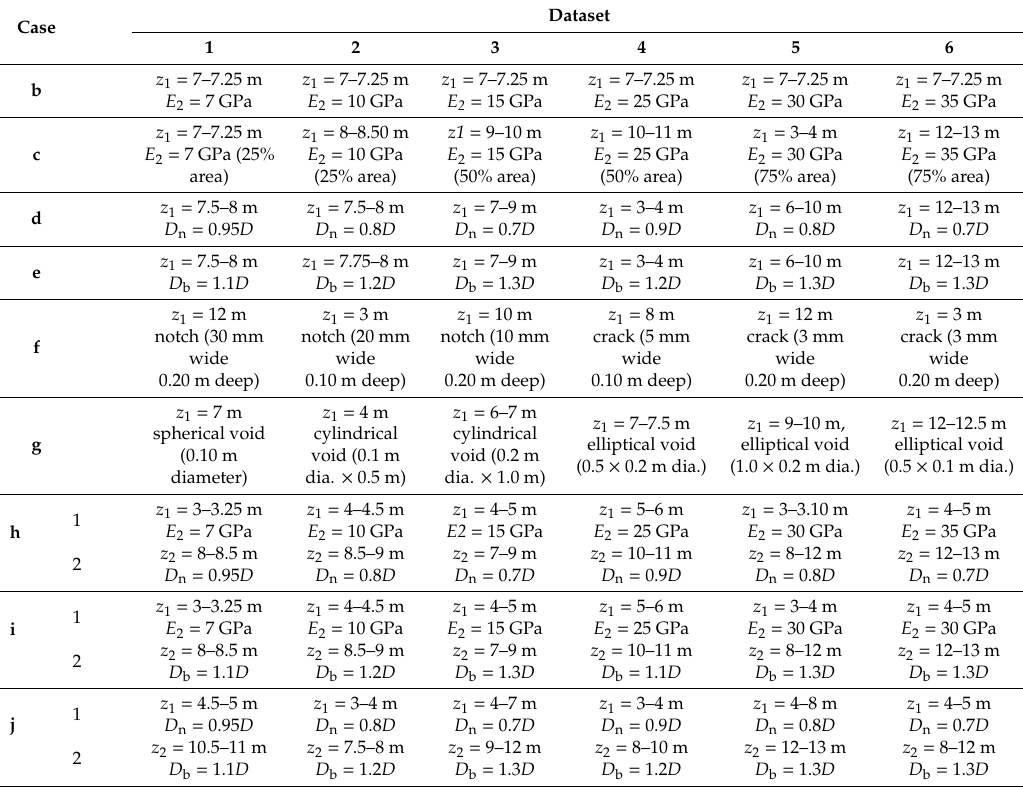
Table 4. Datasets used to verify the proposed pile defect diagnostic